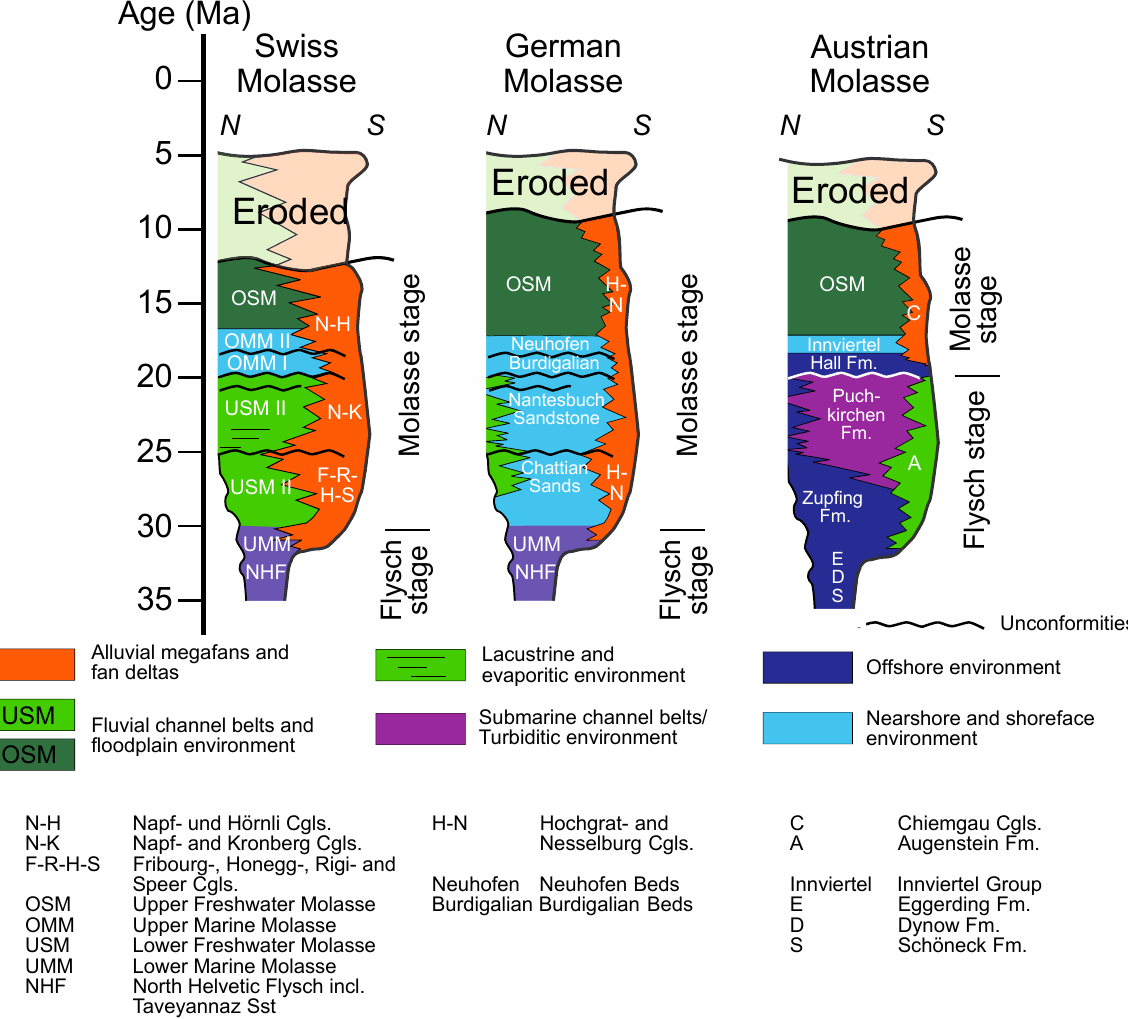
Figure 6. Stratigraphic architectures for the Swiss Molasse basin (between Geneva and Zürich), the German Molasse basin near Munich c. 20 km west of the northward extension of the Giudicaria fault, and the Austrian part of the Molasse basin between Salzburg and Linz (Figure 2). Coarse-grained alluvial megafans and fan deltas established at the Alpine thrust front. Whereas the transition between the Flysch to the Molasse stages occurred at c. 30 Ma in the Swiss Molasse, the same change in basin evolution occurred 10 Ma later in the Austrian part of the basin. Obviously, the strata near Munich chronicle the along-strike transition between the Swiss and Austrian Molasse basin. Interestingly, this is also the region that is situated in the northward extension of the Giudicaria fault where the polarity of the subducted lithospheric mantle slabs is considered to change from an SE to an NNE orientation [29].